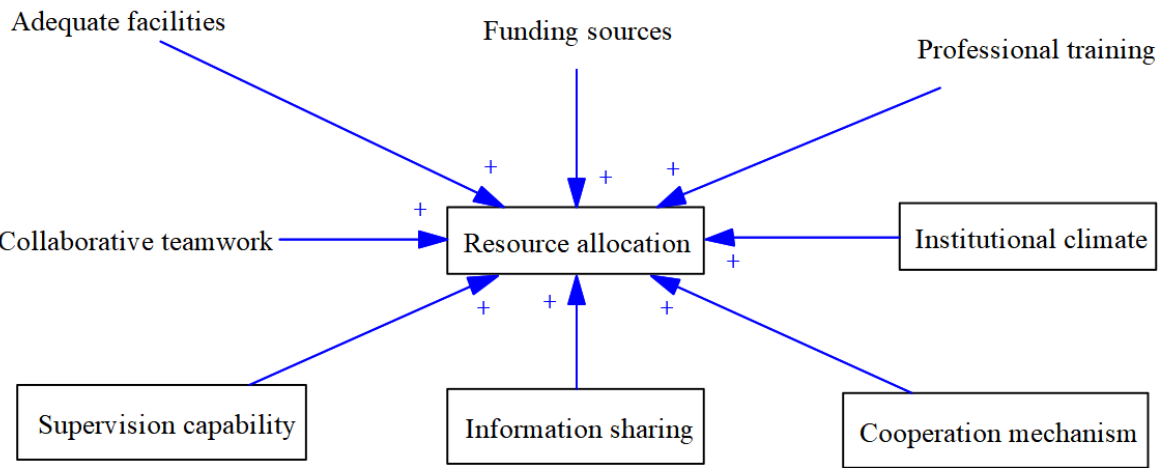
Figure 6. The causal-loop diagram of RA.